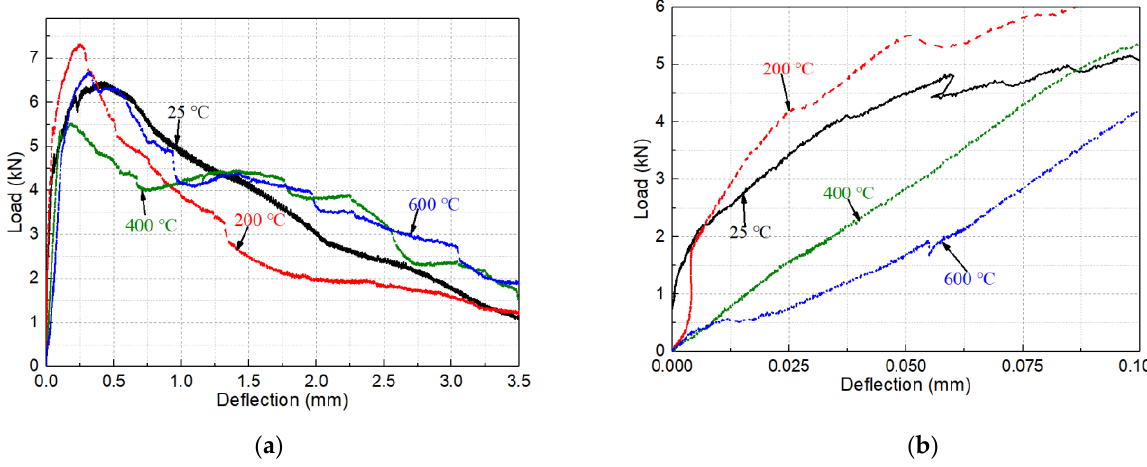
Figure 4. Effect of temperature on the load-deflection curve of heated MSFRC at ( a ) 0–3.5 mm and ( b ) 0–0.1